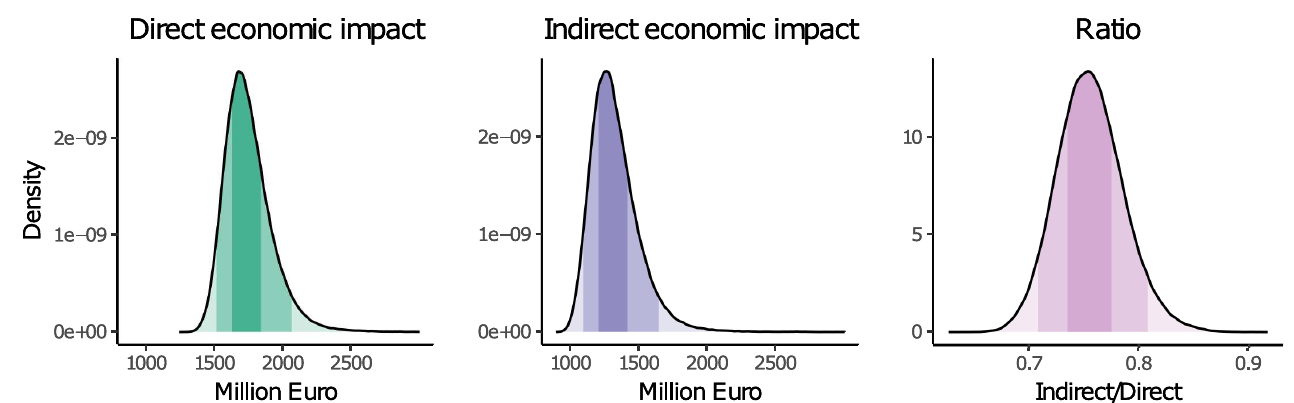
Fig 6. Distributions of estimated direct economic impacts (green), estimated indirect economic impacts (purple) and the ratio (pink) of both for Germany. The different shades of the colours indicate the 50% and 90% intervals.